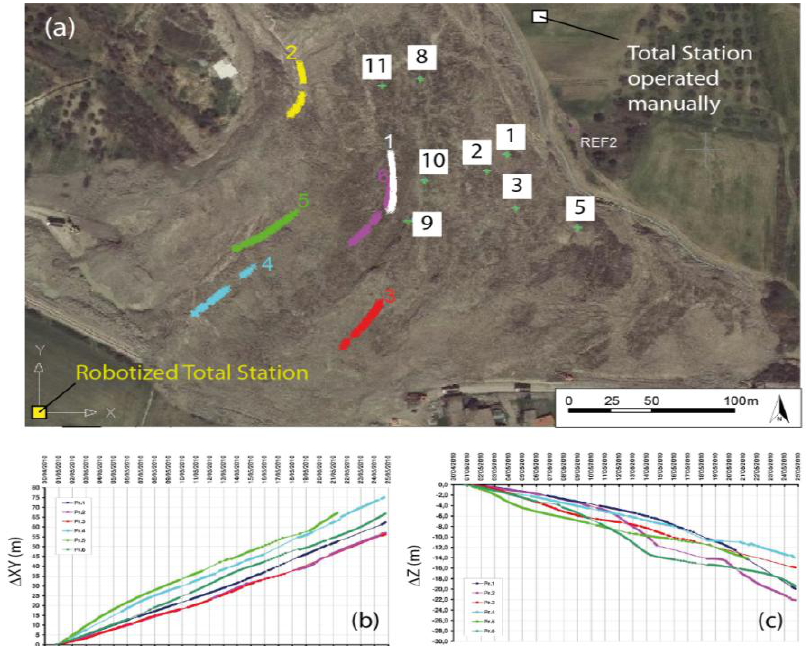
Figure 6. Representation of the displacement occurred at the landslide’s toe during the emergency phase. ( a ) Monitoring network schema, with the traces drawn by the targets monitored via the RTS during the first month. Targets monitored via manual measurements (in the white boxes) show very little displacements; ( b ) and ( c ) are the time series of the planimetric and altimetric displacements, respectively, monitored via the RTS. These representations evidence a non-homogenous landslide evolution, which is very hard to understand by using only 2-D